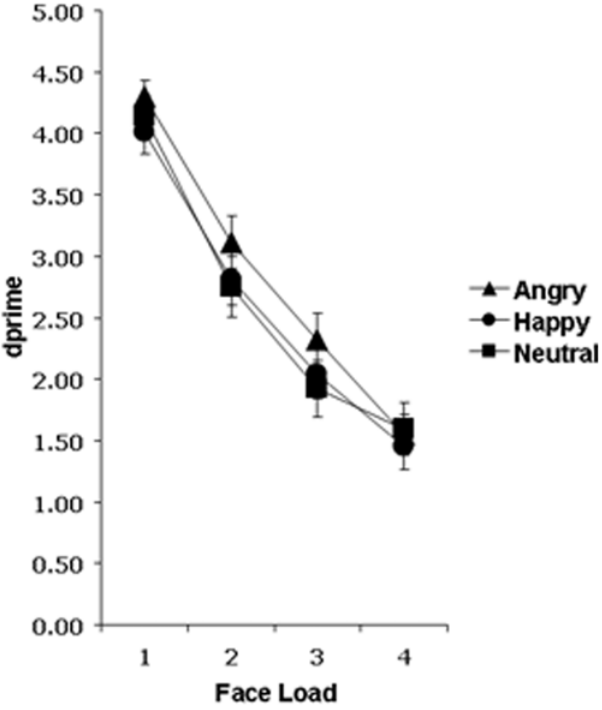
Figure 2. Behavioural performance on angry, happy, and neutral trials for all four face loads are displayed as d’ (dprime) values. A maximum d’ value of 4.66 indicates 100% performance, while a d’ value of zero indicates performance at chance (50%). Participants performed significantly better on the VSTM task when the identities of angry faces were to be remembered, compared to happy or neutral faces. VSTM performance declined as face load increased for all emotional expression conditions. Bars represent 6 1 standard